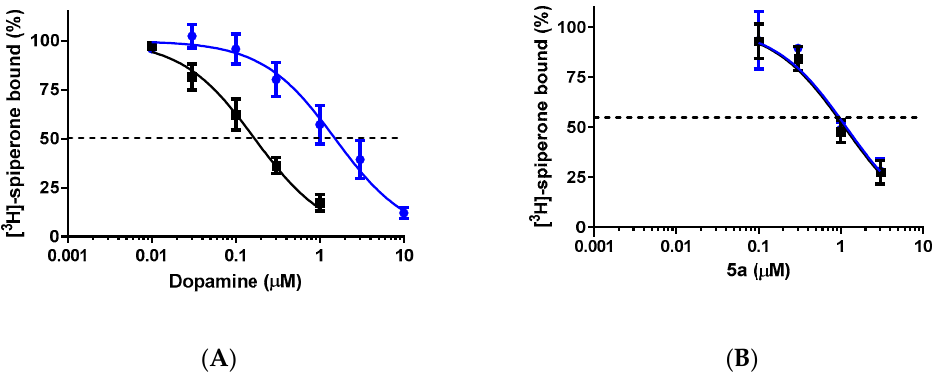
Figure 6. Effect of guanylyl nucleotide on dopamine ( A ) and 5a ( B ) competition for [ 3 H]-spiperone binding to D 3 receptors present in a human cell membrane preparation. The assays were performed in the presence of 5 mM MgCl 2 and 1.5 mM CaCl 2 (black) or the presence of 154 mM NaCl and 1 mM GTP (blue). GTP